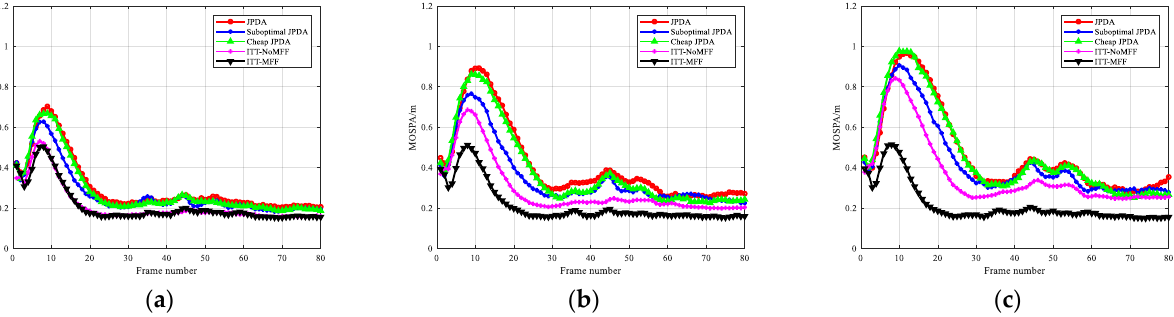
Figure 8. MOSPA comparisons of the four target scenarios with different clutter densities: ( a ) λ = 10 − 5 ; ( b ) λ = 10 − 4 ; ( c ) λ = 10 − 3 .